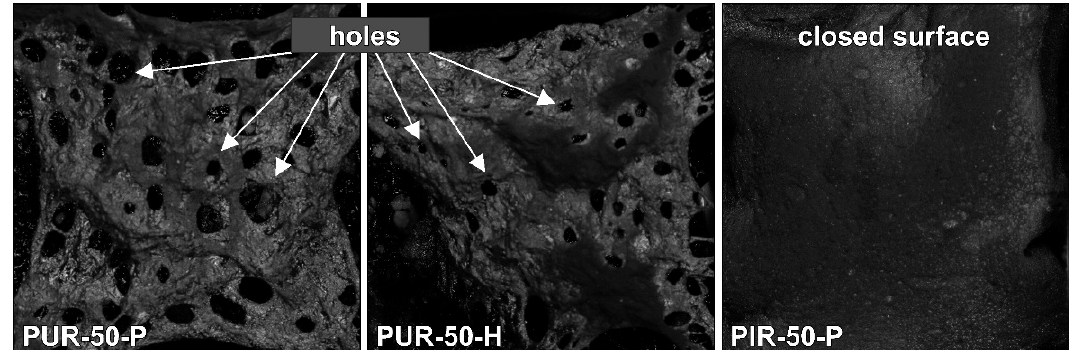
Figure 6. Macro-photograph of residue surfaces of PUR-50-P, PUR-50-H, and PIR-50-P.